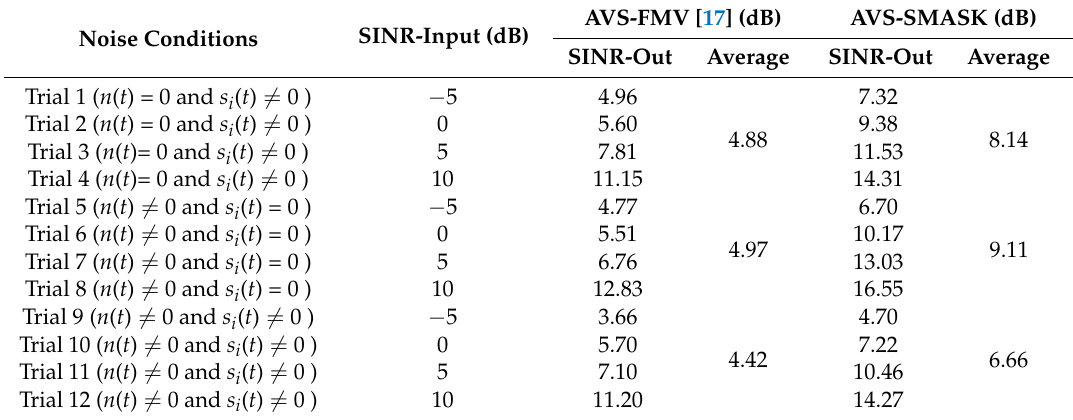
Table 3. Output signal-to-interference plus noise ratio (SINR) under different noise